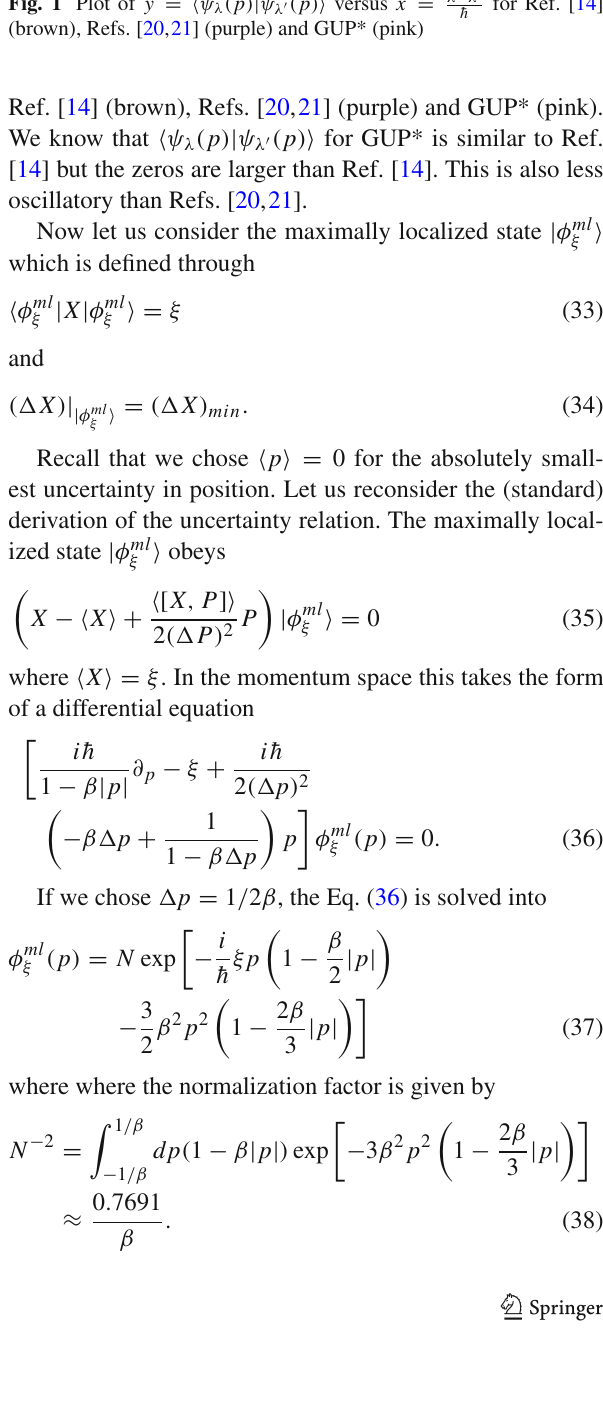
(cid:10) ¯ h for Ref. [14]